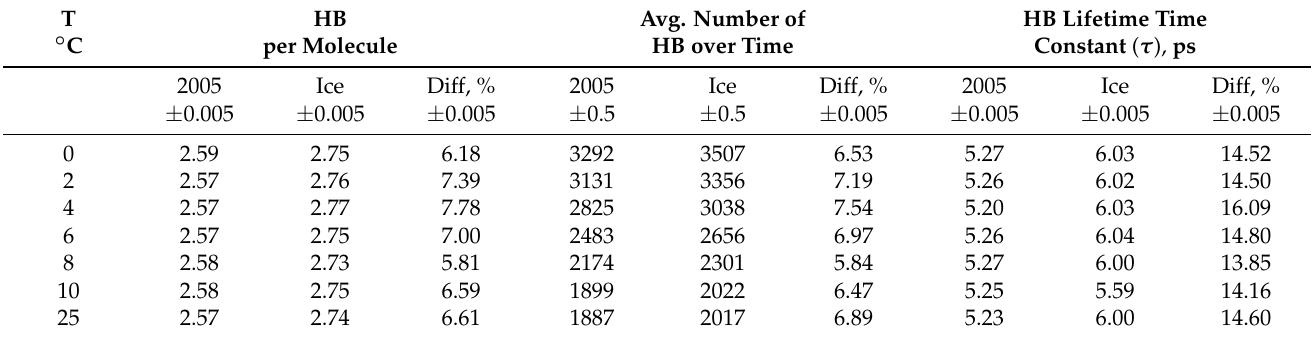
Table 5. Average number of hydrogen bonds (HBs) per donor molecule, the average number of HBs over the simulated time, and the time constants ( τ ) from an exponential fit of HB lifetimes at various temperatures and 0 MPag for pure water systems. 2005: TIP4P/2005 [80]; Ice: TIP4P/Ice [81]; Diff = (Ice − 2005)/2005 ×